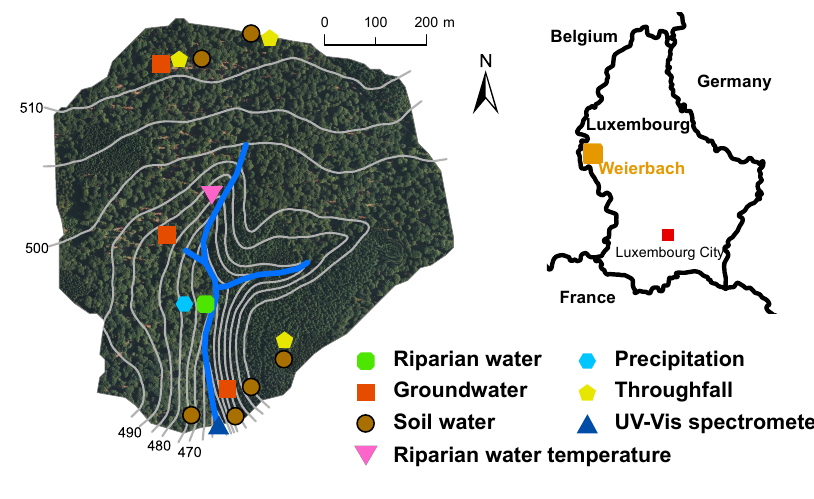
Figure 1. The Weierbach catchment: location of the spectrometer, the end-member sampling points and the measurement location of the riparian water temperature (modified from Schwab et al.,